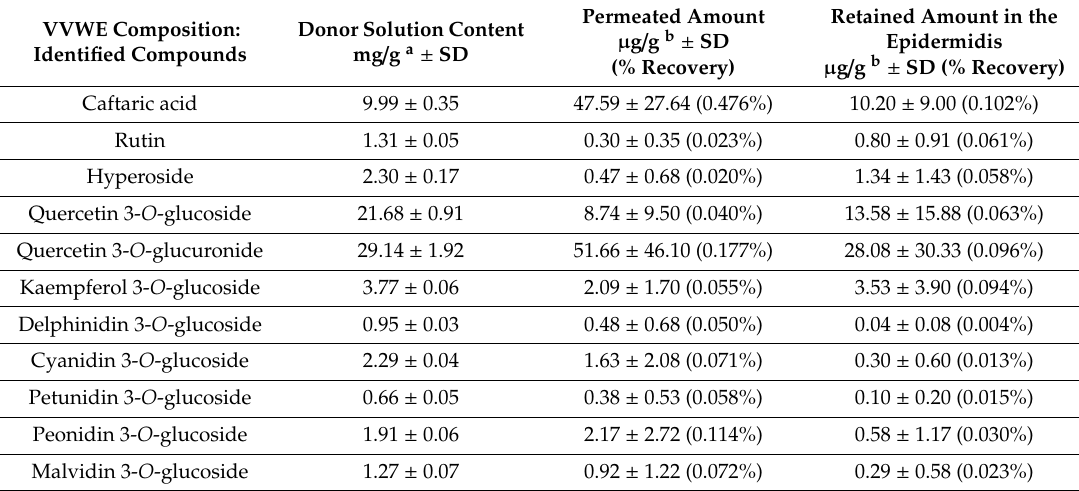
Table 1. Data are expressed as mg( a ) or µ g( b ) of pure compound per g water extract from Vitis vinifera leaves (VVWE) (mean ± SD). Recovery percentage (% recovery) was calculated on the availability in weight of pure compounds after permeation of 150 mg of VVWE in four